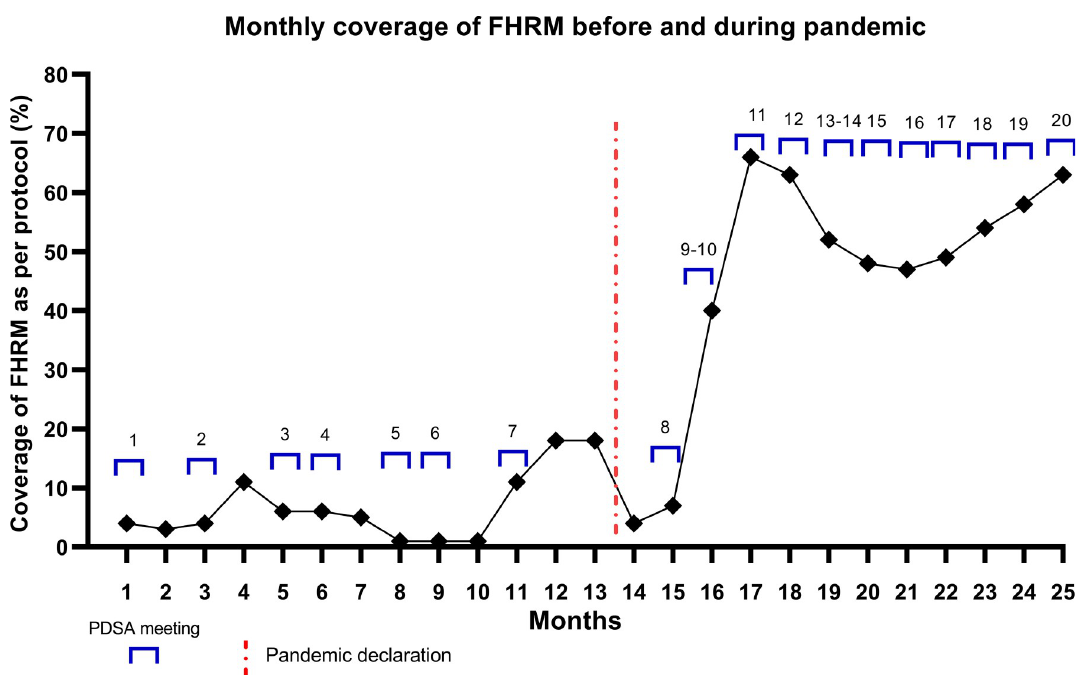
Fig 3. Monthly FHRM practice before and during